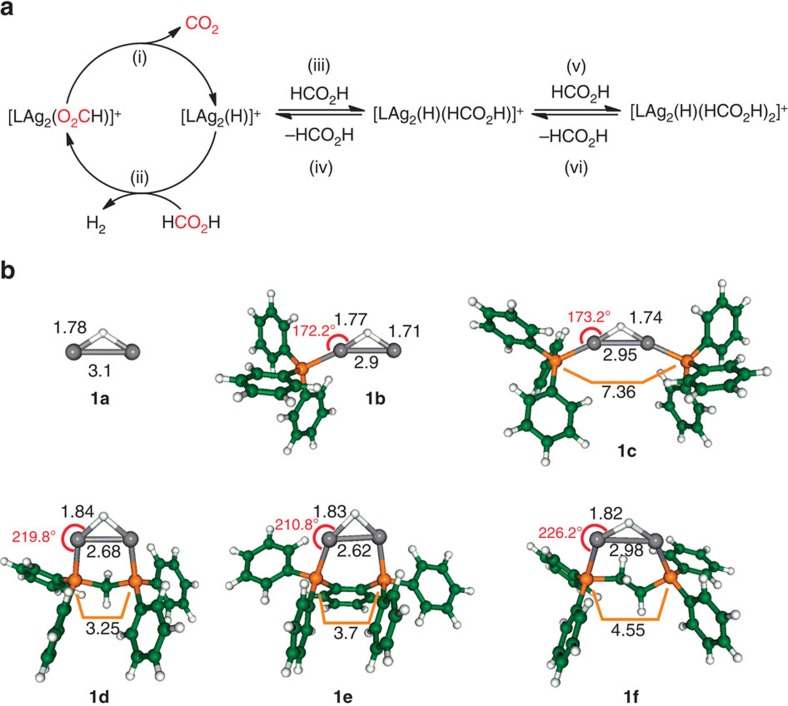
Role of the ligand in the selective decarboxylation of formic acid catalysed by [LAg2(H)]+.(a) catalytic cycle, with following steps: (i), decarboxylation of [LAg2(O2CH)]+ via CID to generate [LAg2(H)]+. (ii), IMR of [LAg2(H)]+ to regenerate [LAg2(O2CH)]+. (iii), IMR of [LAg2(H)]+. (iv), CID of [LAg2(H)(HO2CH)]+ to regenerate [LAg2(H)]+. (v), IMR of [LAg2(H)(HO2CH)]+ with HO2CH to yield [LAg2(H)(HO2CH)2]+. (vi), CID of [LAg2(H)(HO2CH)2]+ to regenerate [LAg2(H)(HO2CH)]+. Most stable DFT-calculated structures of systems examined: (b) 1a, 1b, 1c, 1d, 1e and 1f. DFT calculations used the hybrid functional B3LYP53 with def2-TZVP AO basis set54 for all atoms and corresponding relativistic effective core potential for Ag atoms55. Bond distances are given in Å (black) and P–Ag–H bond angles in degrees (red).